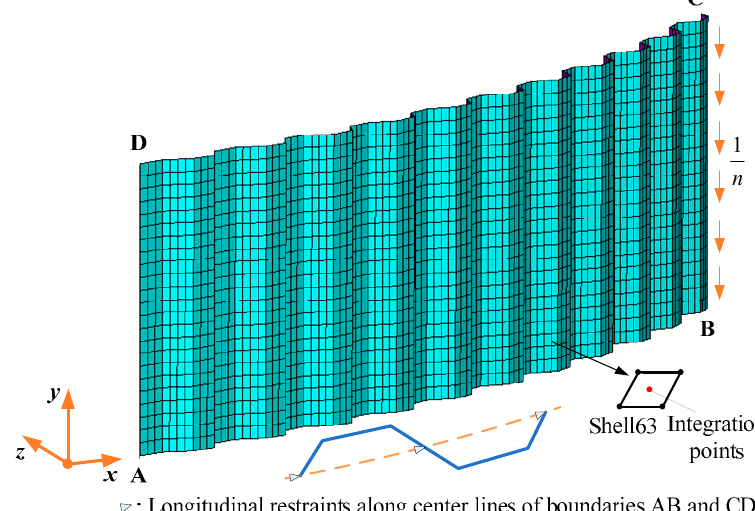
Figure 4. Finite element model of plane curved corrugated steel web (PCCSW).